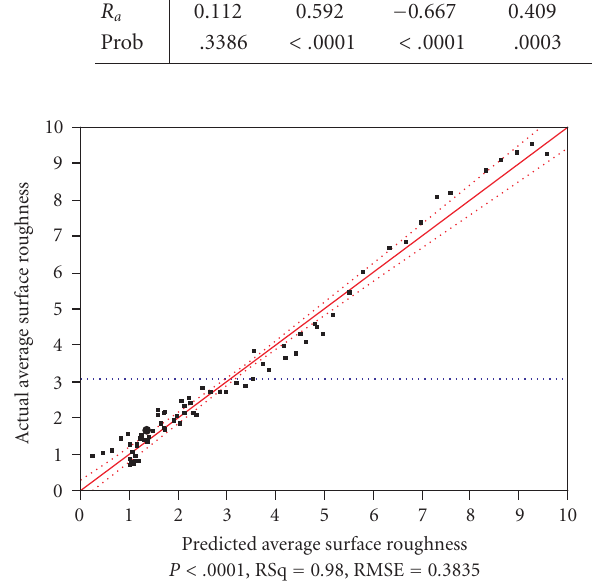
Figure 10: The actual surface roughness versus predicted surface roughness of second-order model.